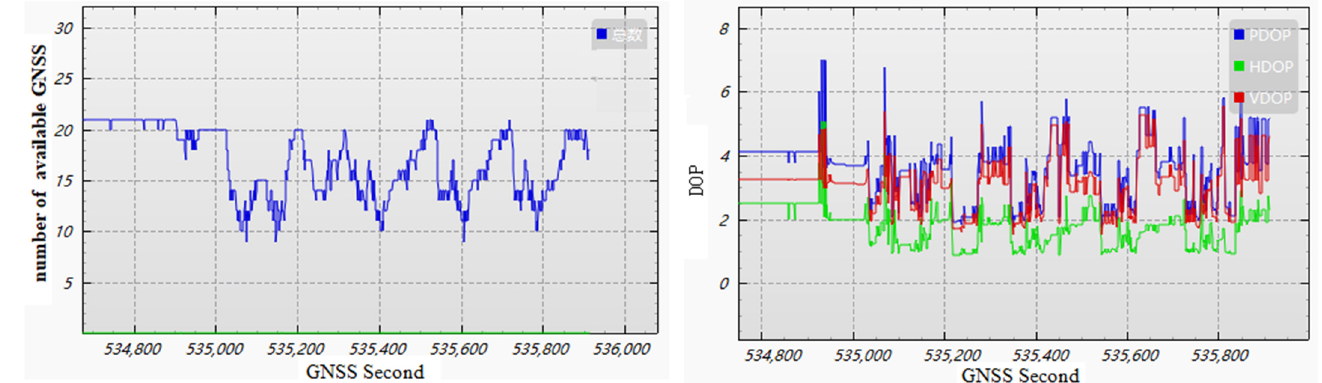
Figure 6. The number of available GNSS satellites and DOP value in the industrial park environment.